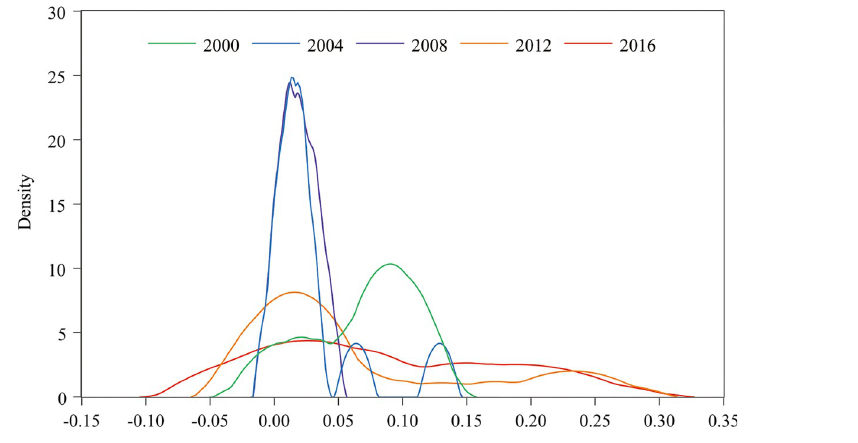
Fig 2. Time series analysis of congestion by kernel density